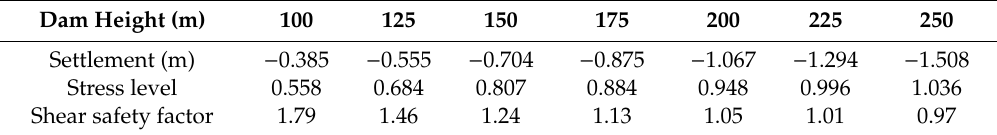
Table 2. Settlement, stress level, and shear safety factor of ACC with di ff erent dam heights.